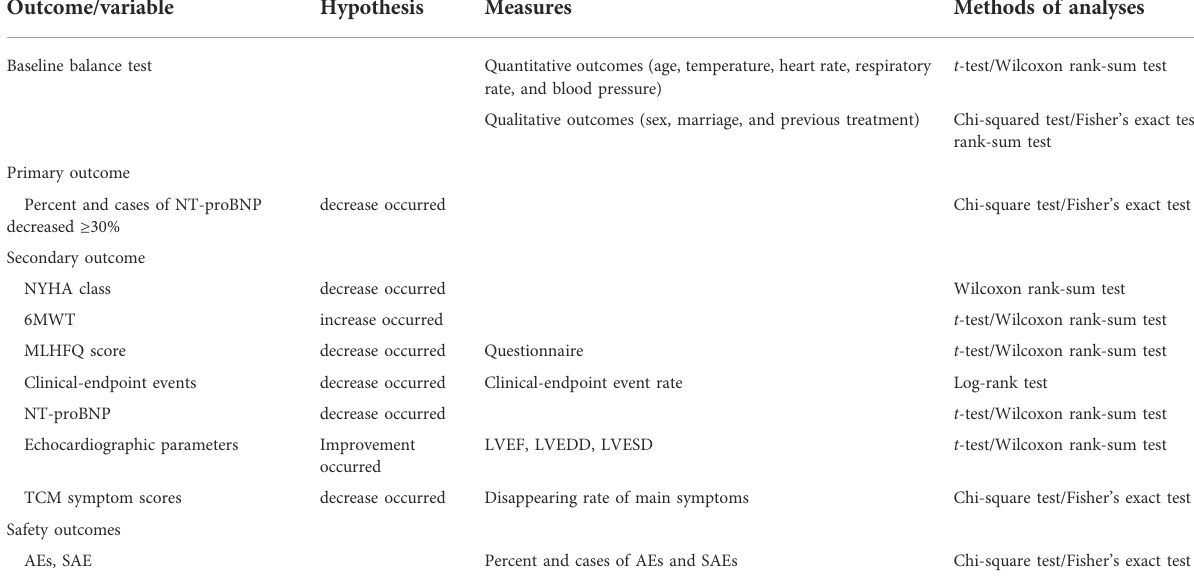
TABLE 3 Outcomes and methods of